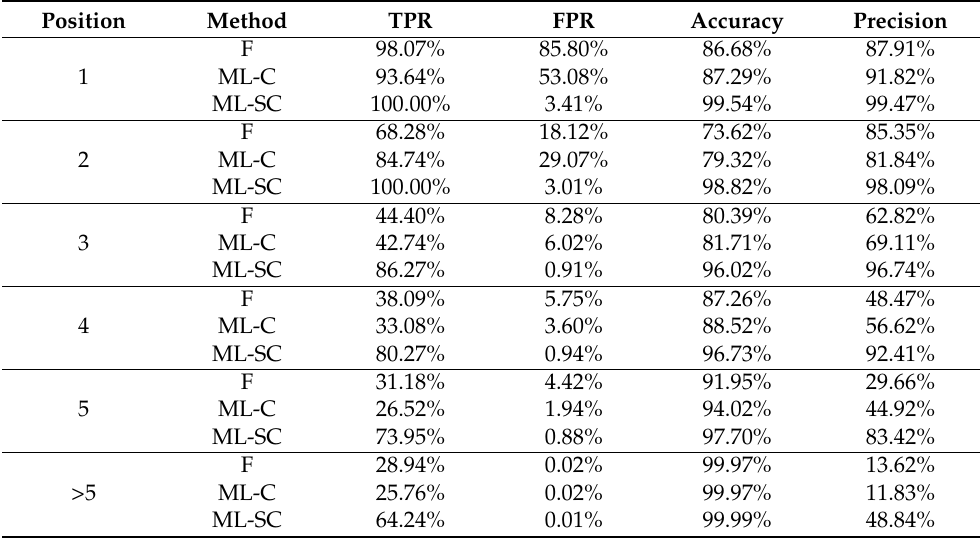
Table 5. TPR, FPR, accuracy and precision comparison across several positions and